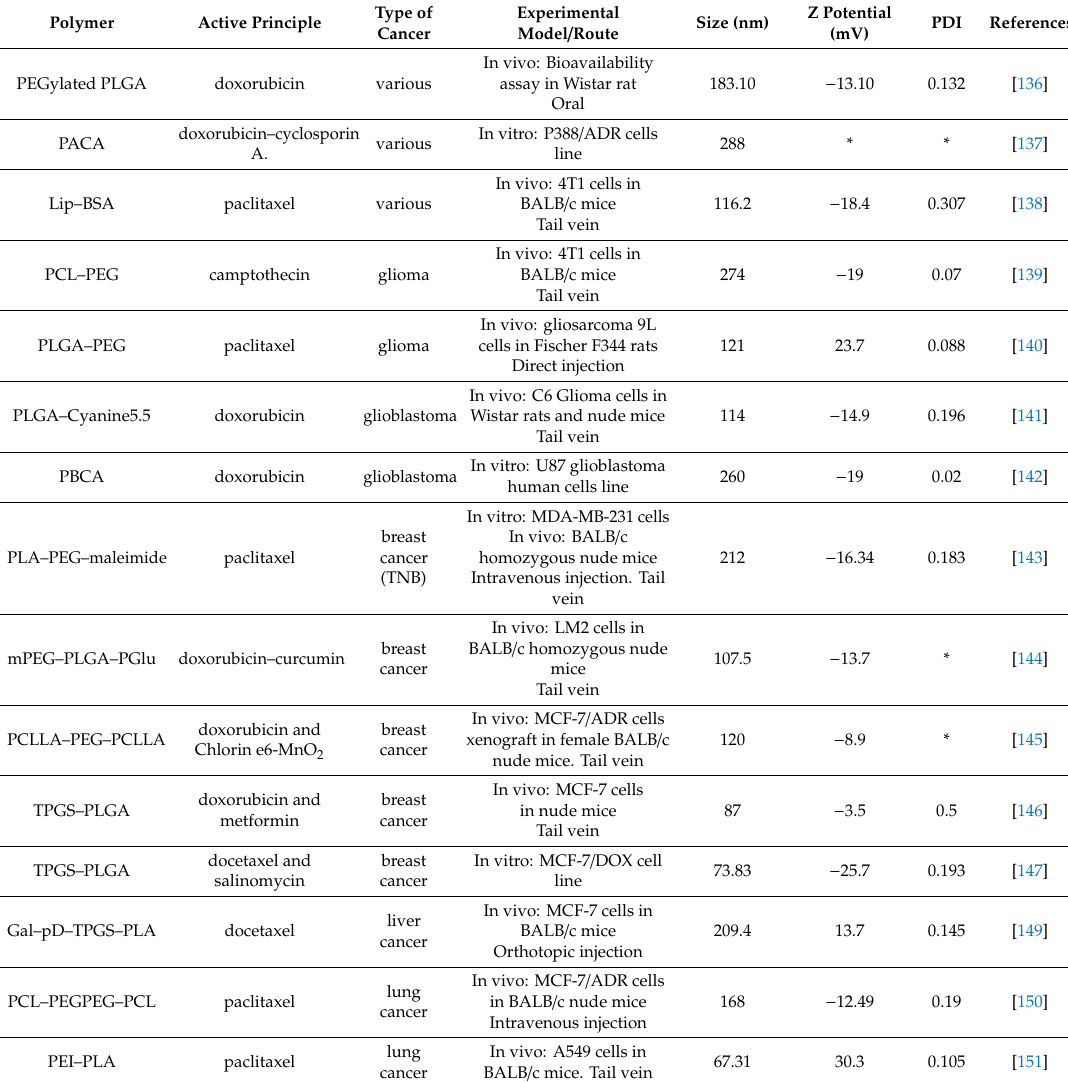
Table 2. Anticancer drug polymer nanoparticles organized by cancer type they are used